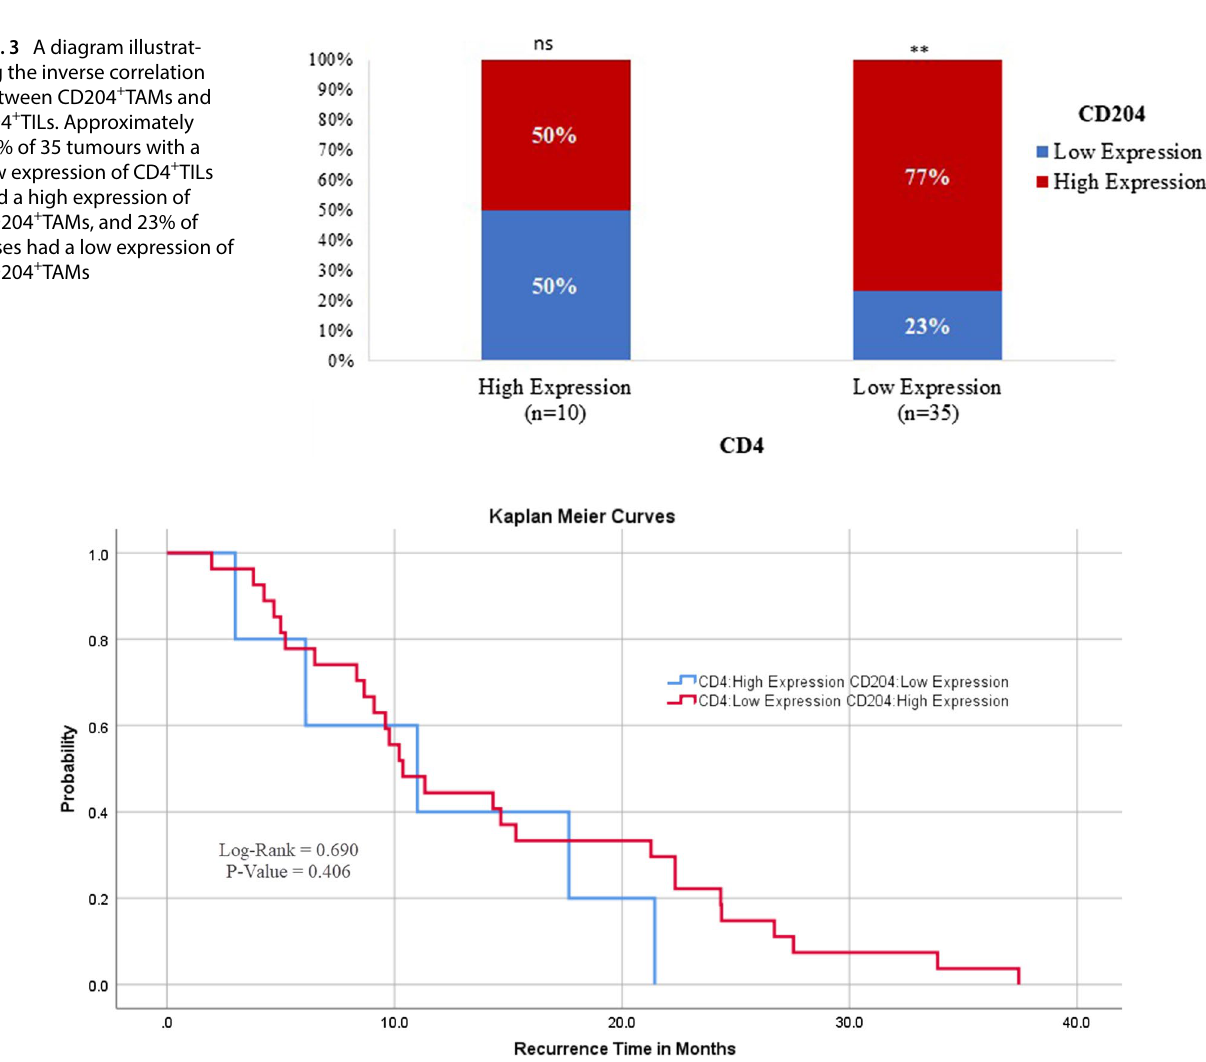
Fig. 4 The relationship between CD204 + TAMs and CD4 + TILs with the RFI. Patients with a high expression of CD204 + TAMs and a low expres- sion of CD4 + TILs had late